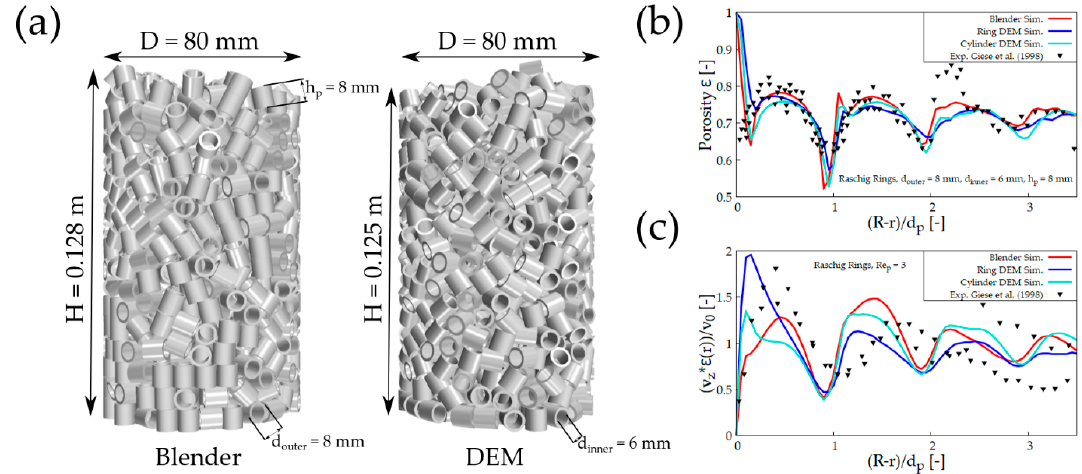
Figure 10. ( a ) Comparison between synthetic generated packing of Raschig Rings, ( b ) radial porosity profiles, and ( c ) velocity profiles. Experiments from Giese et al. [30].